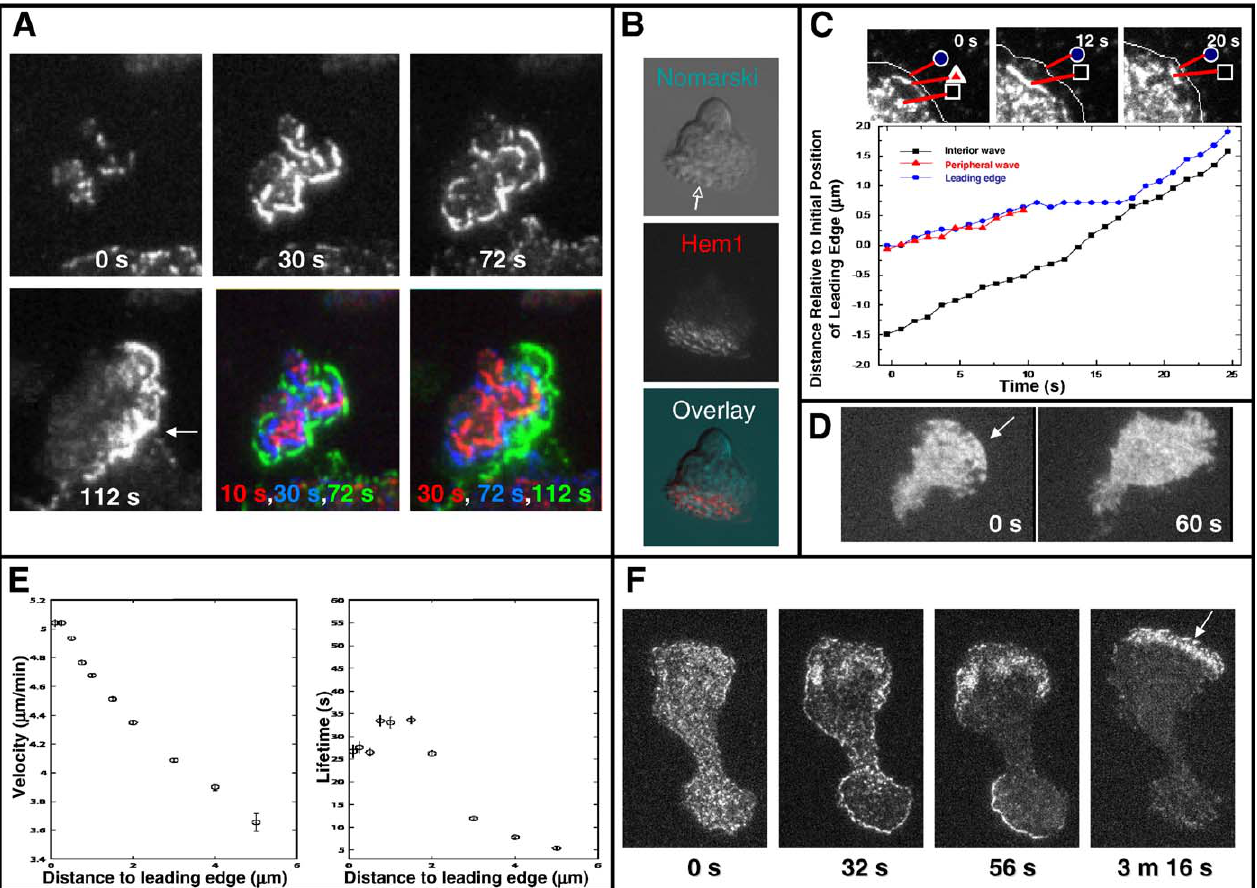
Figure 1. Hem-1 Component of the WAVE2 Complex Localizes to Multiple Propagating Waves in Chemoattractant-Stimulated HL-60 Cells (A) HL-60 cells expressing Hem-1-YFP continually exposed to chemoattractant (20 nM fMLP)—see Video S1 and Video S2. Hem-1 initially concentrates in foci, which form outwardly propagating waves that eventually develop into a polarized accumulation of Hem-1 at the leading edge (denoted by arrow at 112 s). Panels five and six overlay successive Hem-1 distributions in red, blue, and green successively. (B) Hem-1 waves concentrate at the ruffled leading edge of polarized cells (leading edge identified by arrow in Nomarski panel). Nomarski (Video S3), Hem-1-YFP (Video S4), and overlay (Video S5) of polarized HL-60 cell exposed to 20nM fMLP. (C)LeadingedgeadvanceishighlycorrelatedwithunderlyingHem-1waves.Thetoppanelshowspositionofleadingedge(bluecirclesandwhitecelloutline), mostperipheralHem-1wave(redtriangles),andmoreinteriorHem-1wave(blacksquares).Astheperipheralwaveisextinguished,theleadingedgestallsand resumes movement once the interior wave approaches the leading edge. The lower panel displays distances relative to initial position of leading edge. (D) TIRF membrane control. C5A receptor-GFP (which is uniformly distributed on the plasma membrane) is uniformly distributed in the TIRF field. An arrow in the first panel denotes the leading edge. (E) Hem-1 waves exhibit a spatial gradient in velocity (first panel) and lifetime (second panel) with respect to the leading edge. (F) HL-60 cells acutely stimulated with chemoattractant (20 nM fMLP) produce a uniform field of Hem-1 spots, which asymmetrically disappear, are retained at one end of the cell (arrow), and begin generating Hem-1 waves (Video